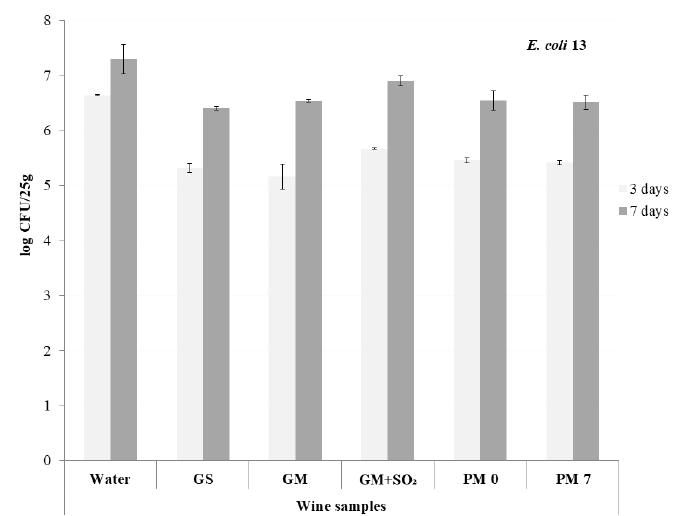
Figure 3. Count of E. coli (WDCM00013) in wine-marinated seabass ( Dicentrarchus labrax ); (GS—standard white wine, GM and GM + SO 2 —macetared white wine with and without SO 2 , PM 0—rosé, PM 7—macerated redwine) after 3 and 7 days of storage at 4 ± 1°C.